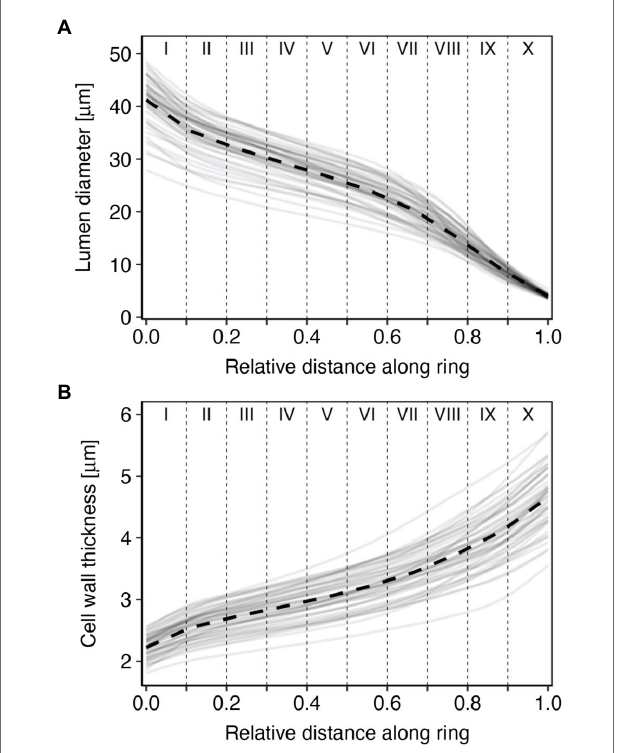
FIGURE 3 | Annual (gray solid lines) and mean (black dashed lines) standardized tracheidograms of (A) lumen diameter and (B) cell wall thickness (CWT) for the five sampled trees at Nutrioso and Black River for the years 1966–2015. Roman numerals indicate tree-ring sectors, from the beginning (sector I) to the end of the ring (sector